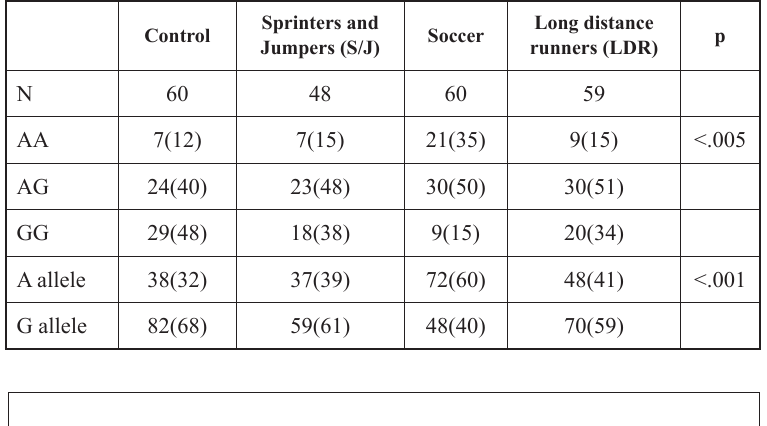
Figure 1. ACSL A/G genotype frequencies among national-team level soccer players, Long-Distance Runners (LDR), Sprinters and Jumpers (S/J), and controls χ 2 = 18.193, df = 2, p = 0.00011, genotype frequency, soccer vs. controls χ 2 = 9.711, df = 2, p = 0.00778, genotype frequency, soccer vs. S/J χ 2 = 18.101, df = 2, p = 0.00011, genotype frequency, soccer vs. LDR χ 2 = 19.401, df = 1, p =